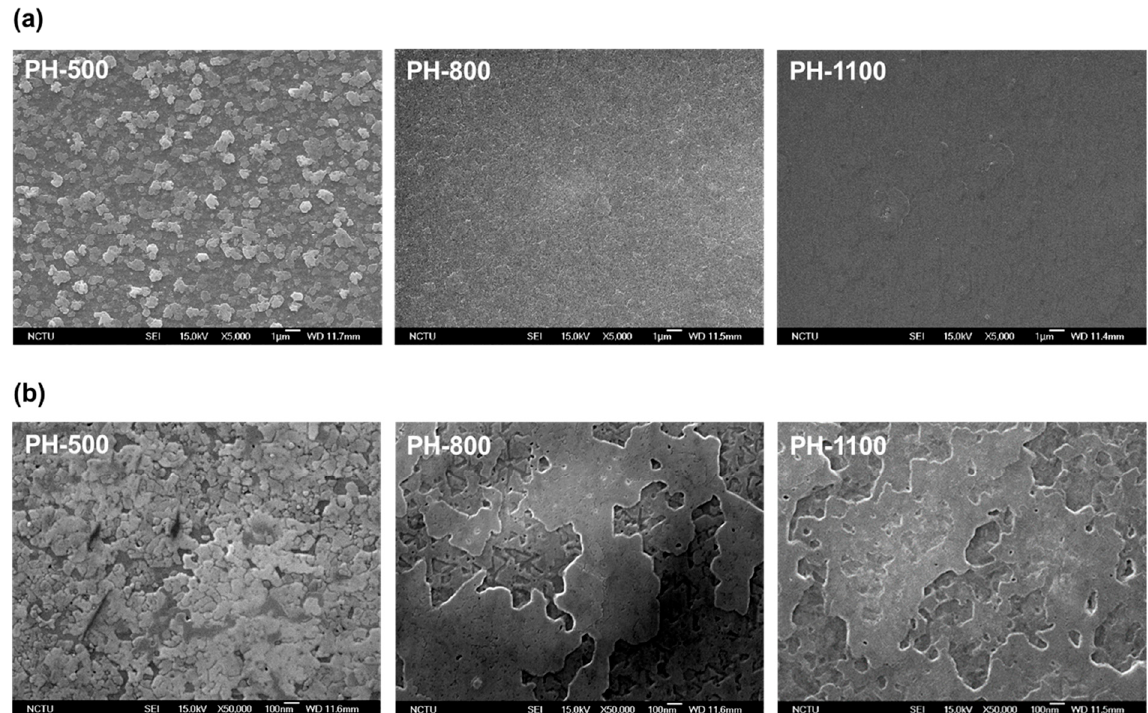
Figure 3. Plan-view SEM images of the GaN nucleation layers on preheated ( − 2 0 1) β -Ga 2 O 3 wafers—( a ) 5000× and ( b ) 50,000× magnification—of PH-500, PH-800, and PH-1100.